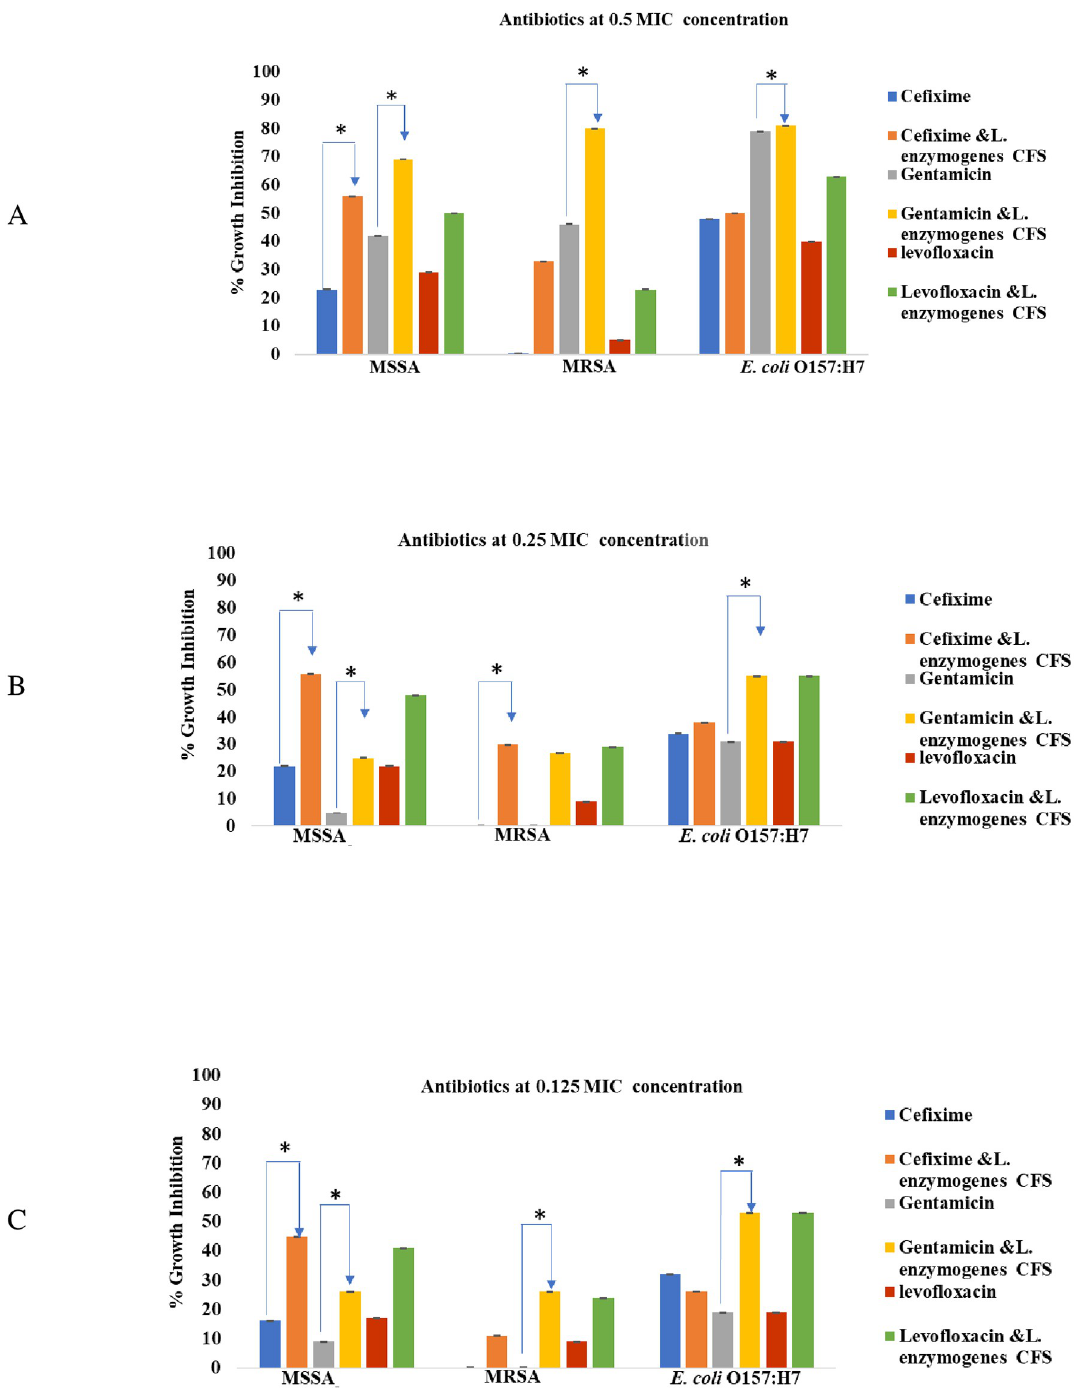
Fig 4. L . enzymogenes CFS-antibiotics modulating effect against the tested pathogens. � Statistical significance p < 0.005.